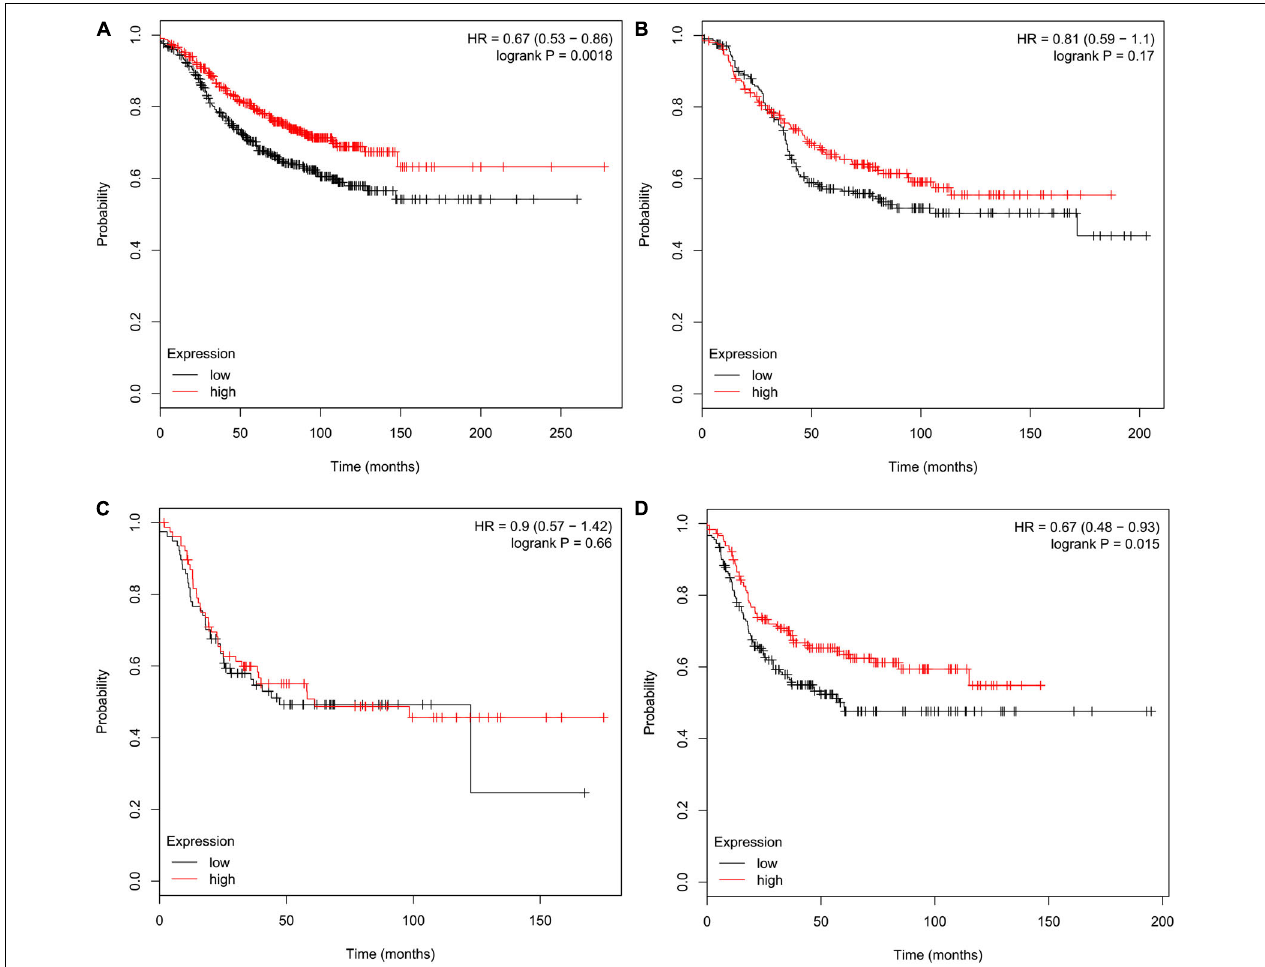
FIGURE 6 | Effect of CMTM5 mRNA expression levels on relapse-free survival in different breast cancer subtypes using the Kaplan–Meier plotter. (A) Luminal A, (B) luminal B, (C) HER2 +, and (D) basal-like